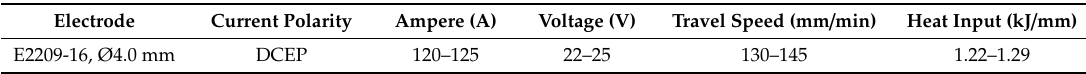
Table 2. Welding Parameter for Duplex Stainless Steel (DSS) weld